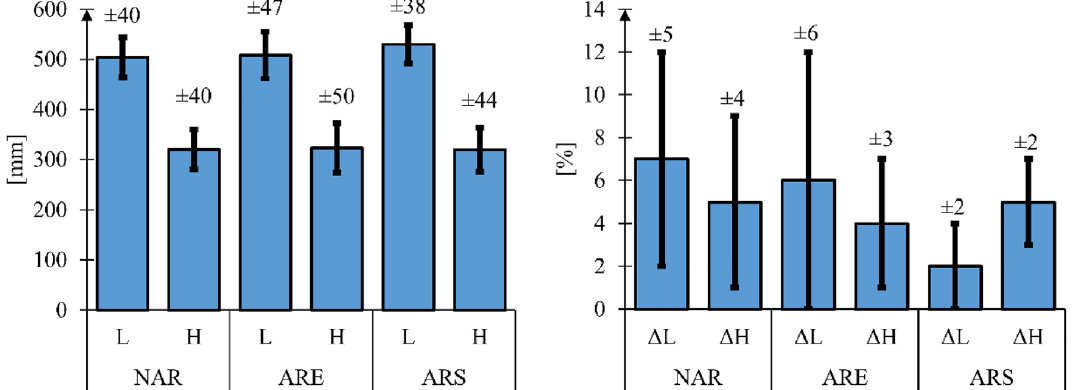
Figure 10. Summary of L and H parameters of the hand position when propelling a wheelchair with no modifications (NAR), with a flexible anti-rollback system (ARE) and with a stiff anti-rollback system—for 10 subjects, where: L—length of the area, H—height of the area, ΔL—% difference in length relative to the largest value for a given subject, ΔH—% difference in height relative to the largest value for a given subject. All mean values were determined at a 95% confidence interval ( p = 0.05).